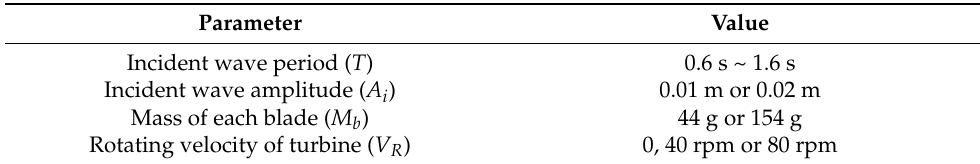
Table 1. Experimental variables.